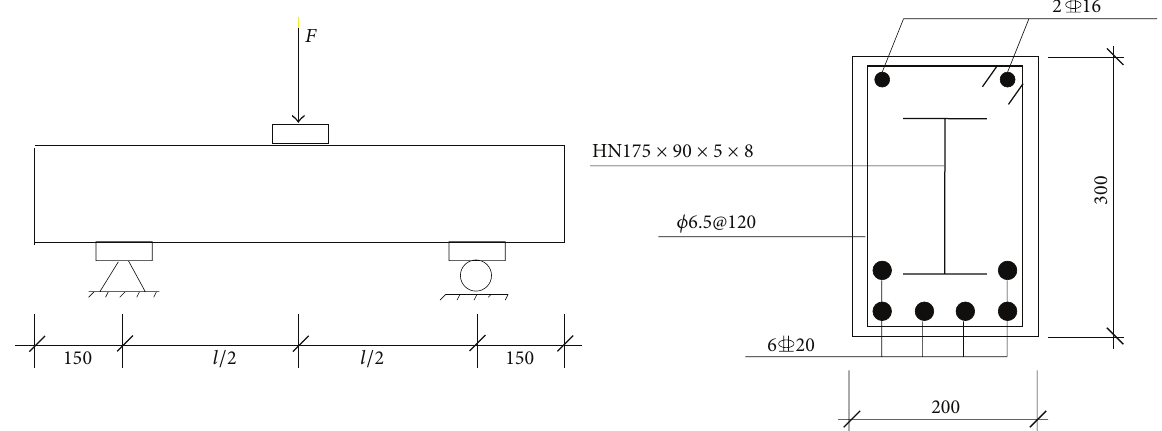
Figure 2: Test apparatus and specimen details.